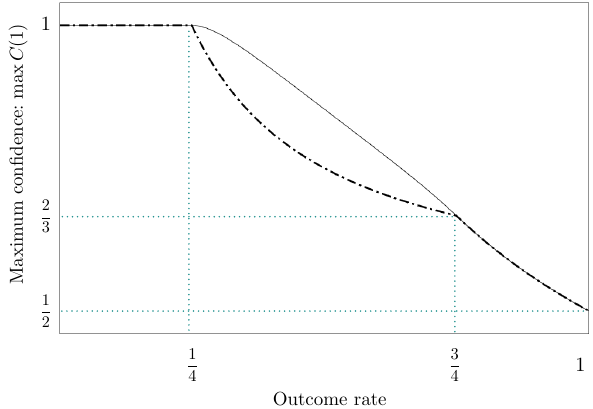
FIG. 7. In two-state discrimination between | 0 (cid:13) and ( | 0 (cid:13) + √ | 1 (cid:13) )/ 2, the certifiable MCM in the first detector, denoted by max C ( 1 ) , is plotted with respect to the outcome rate η 1 . The certifiable MCM is shown in both quantum theory (solid line) and in a noncontextual ontological model (dotted line). A low detection rate η 1 ≤ 1 / 4 is compatible with UD. The contextual advantages exist whenever an outcome rate is within the range ≤ 3 / 4. However, no contextual advantage can be obtained if η 1 an outcome rate is too high for η 1 > 3 /